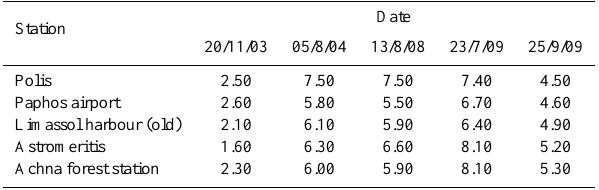
Table 1. ETo (mm/day) using FAO-56 method.